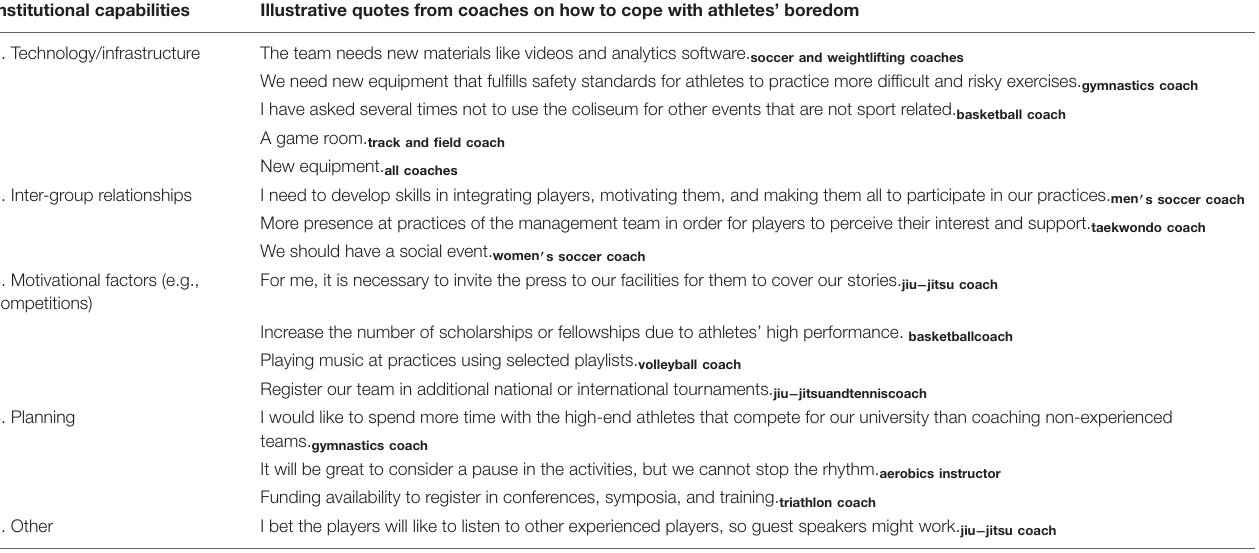
TABLE 4 | Coaches feedback on how to deal with athletes’